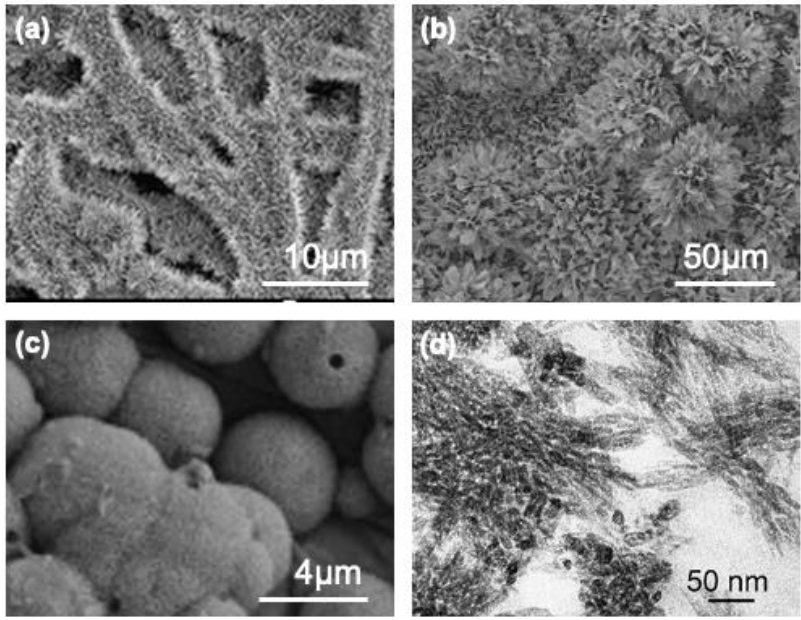
Figure 9. Morphologies of the deposits obtained in apatite mineralized eggshell membranes. ( a ) Needle-like apatite deposits. Image. Reproduced from Xu et al. [149]. Copyright Elsevier (License number 5471980705584). ( b ) Flower-like apatite aggregates. Image reproduced from Zhang et al.